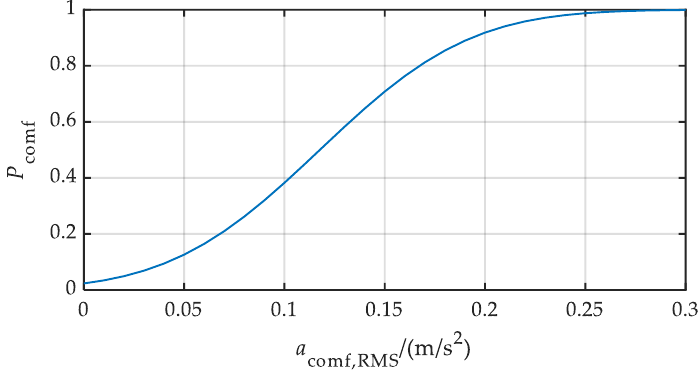
Figure 5. Distribution function of a comfort indicator. To assess an overall comfort rating, the three scaled indicators 𝑃 comf , 𝑃 sick , and 𝑃 𝑗 need to be merged into a single value. We combined the three values compared to norm